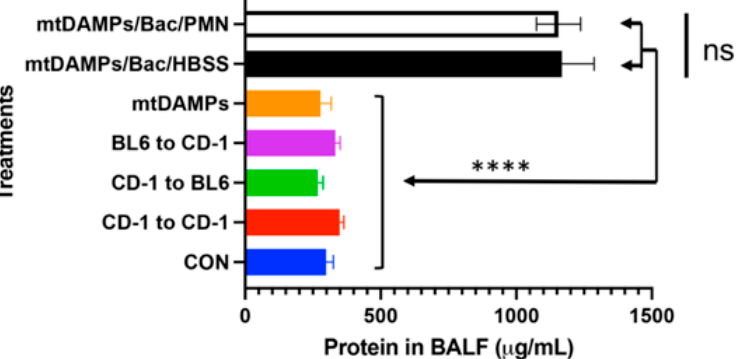
Figure 4. Exogenous PMN do not injure the lung. Lung injury was evaluated by assaying protein leak into BAL fluids. CON: saline i.t. (n = 5), CD-1 to CD-1: BM-PMN from CD-1 mice were instilled i.t. into CD-1 mice, 2 × 10 6 i.t. (n = 5), CD-1 to BL6: BM-PMN from CD-1 mice